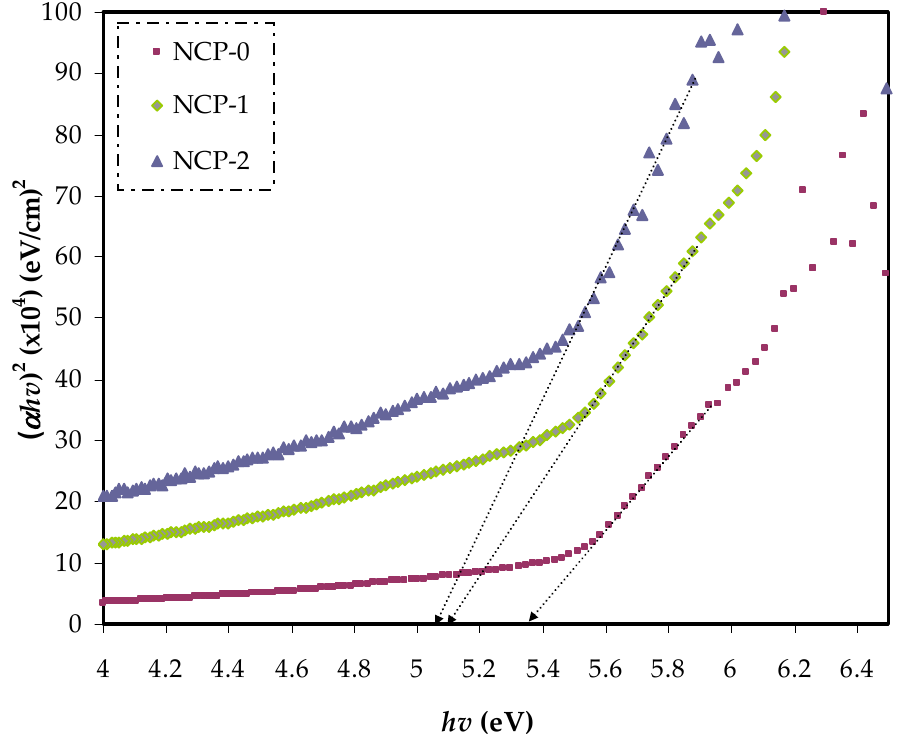
Figure 8. ( α h υ ) 2 v photon energy for NCP-0 and composite samples.